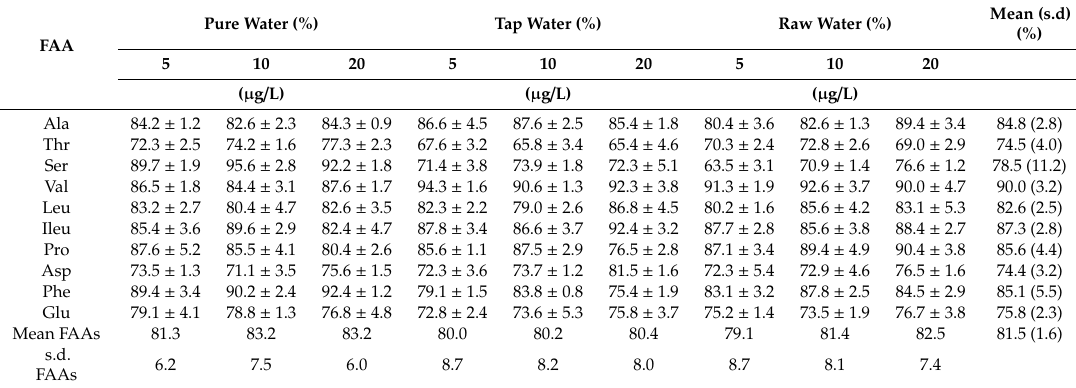
Table 4. SPE-derivatization recovery rates of FAAs in pure water, tap water, and raw